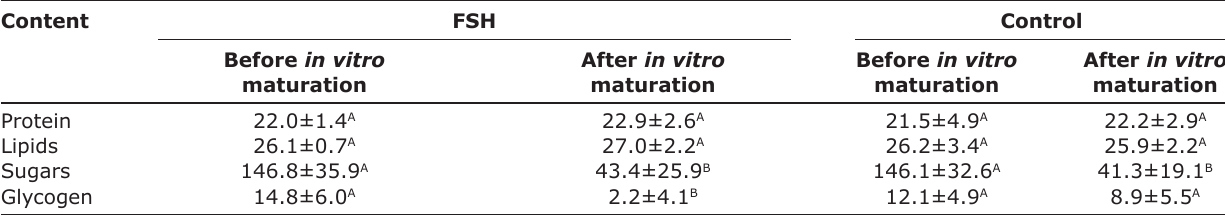
Table-3: Media composition before and after exposure of bovine cumulus-oocyte complexes to FSH or its vehicle (control) during in vitro maturation for 22 h. Content FSH Control Before in vitro After in vitro Before in vitro After in vitro maturation maturation maturation